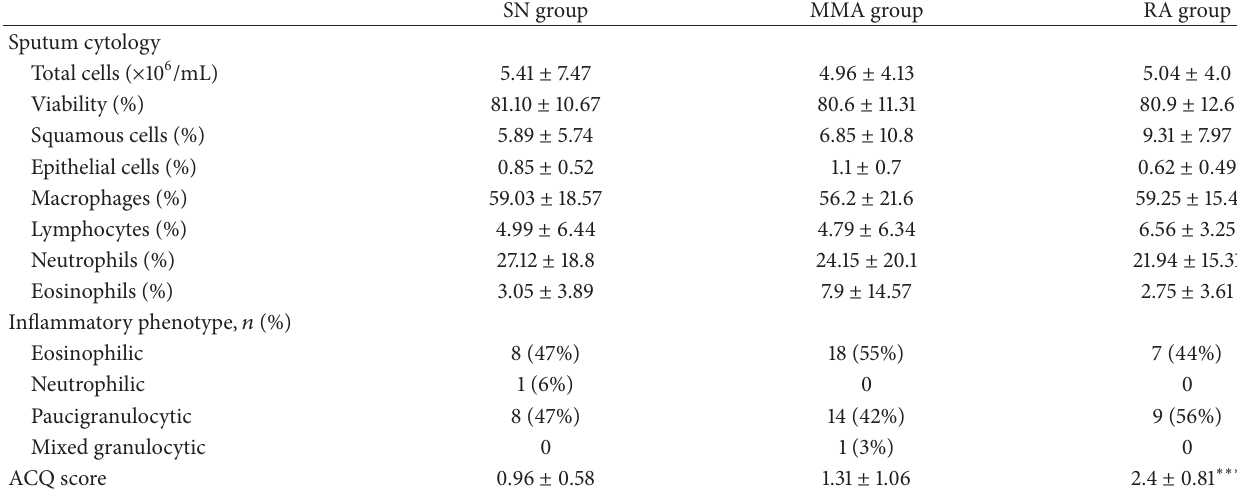
Table 2: The cellular profile of sputum, asthma phenotypes, and ACQ score at visit 1. Values are presented as mean ± SD.